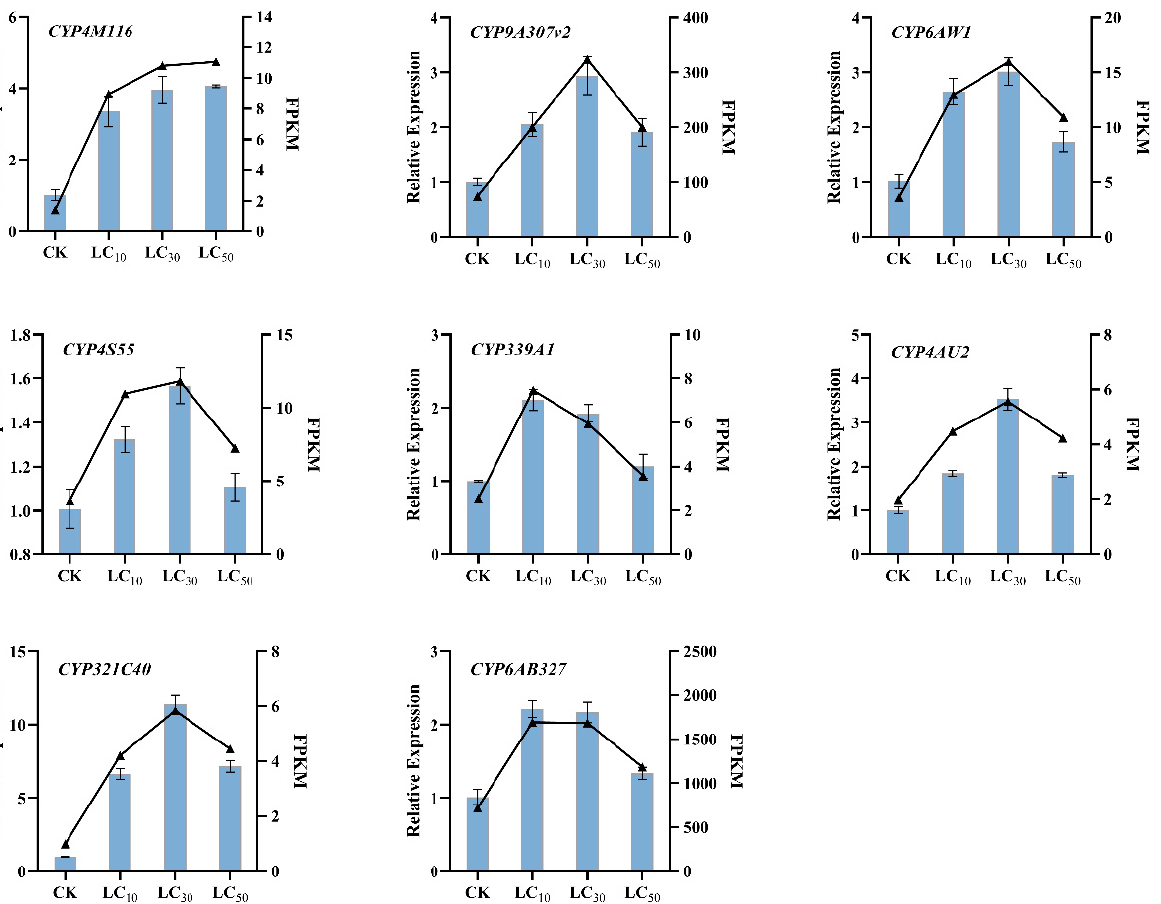
Figure 5. Validation of P450 genes expressions by RT-qPCR. Relative expression of the eight genes based on RT-qPCR is represented by a his- togram with standard error, and RNA-seq data are represented by a line chart. Each value represents the mean ± SE of three replicates (n = 3).